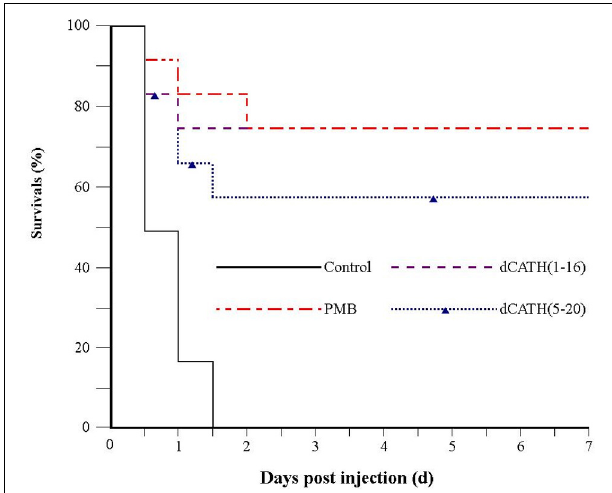
FIGURE 8 | Survival of mice from LPS-induced lethal infection by dCATH(1–16) or dCATH(5–20). Mice were subjected to a lethal dose of LPS, followed by i.p. injection of CATH(1–16) or dCATH(5–20) at 10 mg/kg or an equal volume of PBS as controls ( n = 12). Survival was recorded every 12 h over 7